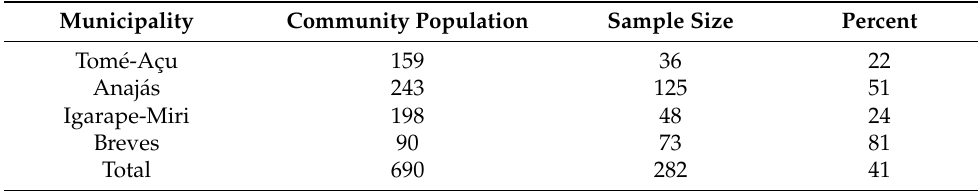
Table 1. Case Study